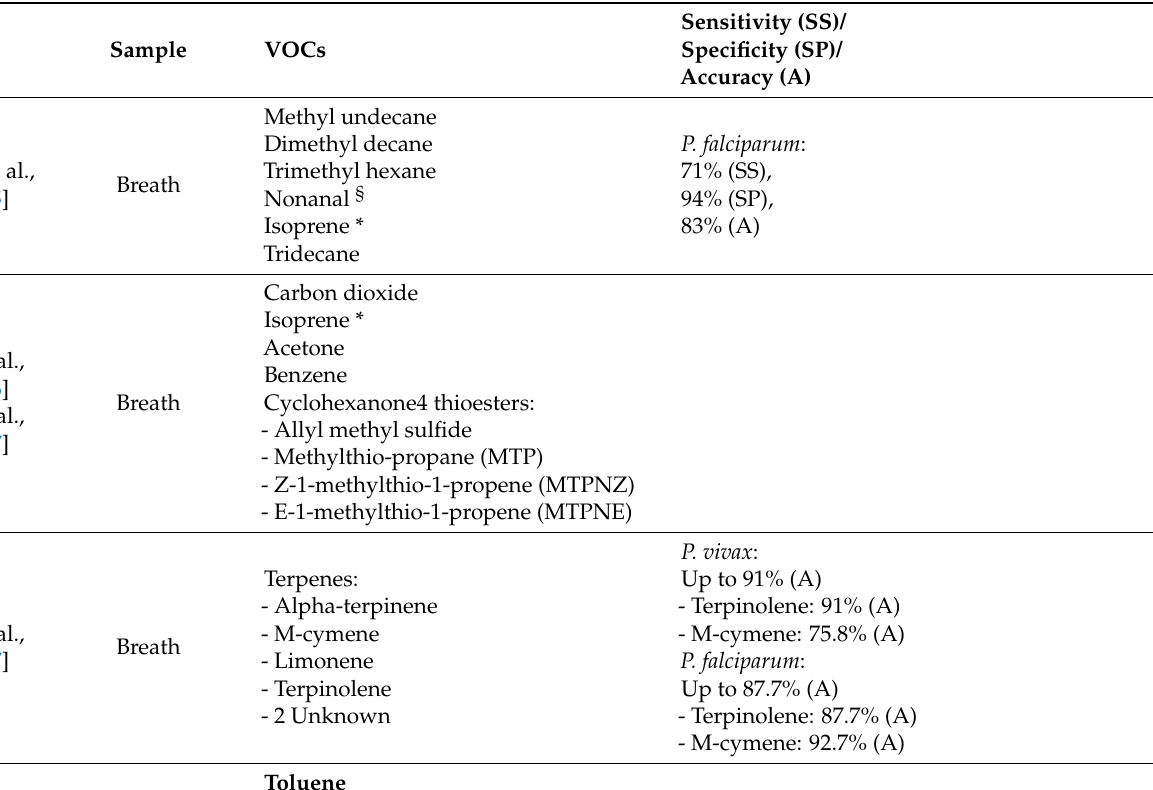
Table 1. Malaria-associated VOCs found in infected